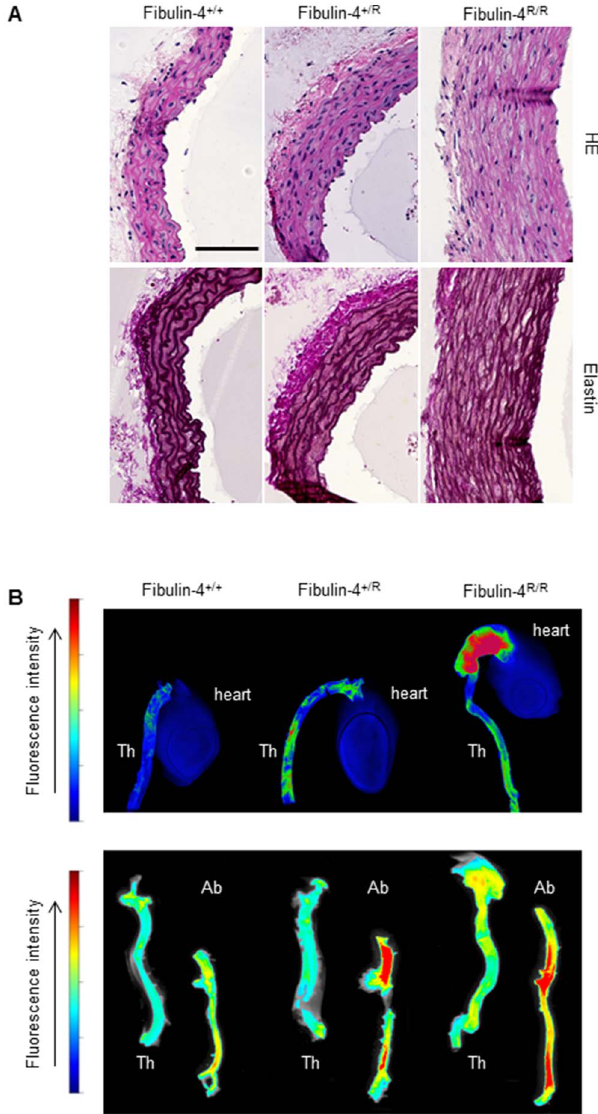
Figure 2. Degenerative arterial wall changes and increased MMP activity in Fibulin-4 animals. (A) Comparison of the architecture of the aortic wall in Fibulin-4 + / + , Fibulin-4 + /R , and Fibulin- 4 R/R mice. Top: Haematoxylin- eosin (HE) staining of cross-sections from 120 day-old mice. Bottom: Aberrations in elastic laminae in Fibulin-4 R/R mice, consisting of a fragmented and disorganized appearance of elastin in the medial layers of the aorta. In heterozygous Fibulin-4 + /R mice, interrupted elastin layers and areas in the aortic wall with a granular appearance of elastic laminae are present, albeit milder, indicating a gene dosage effect. Scale bar indicates 100 m m (B) Ex-vivo analysis shows a gradual increase in active MMPs as detected with the activatable NIRF probe MMPSense 680. Within the aneurysmal lesions in the thoracic aorta (Th), as well as in the abdominal aorta (Ab) of Fibulin- 4 + /R and Fibulin-4 R/R mice, a graded increase in MMP activity is detected.